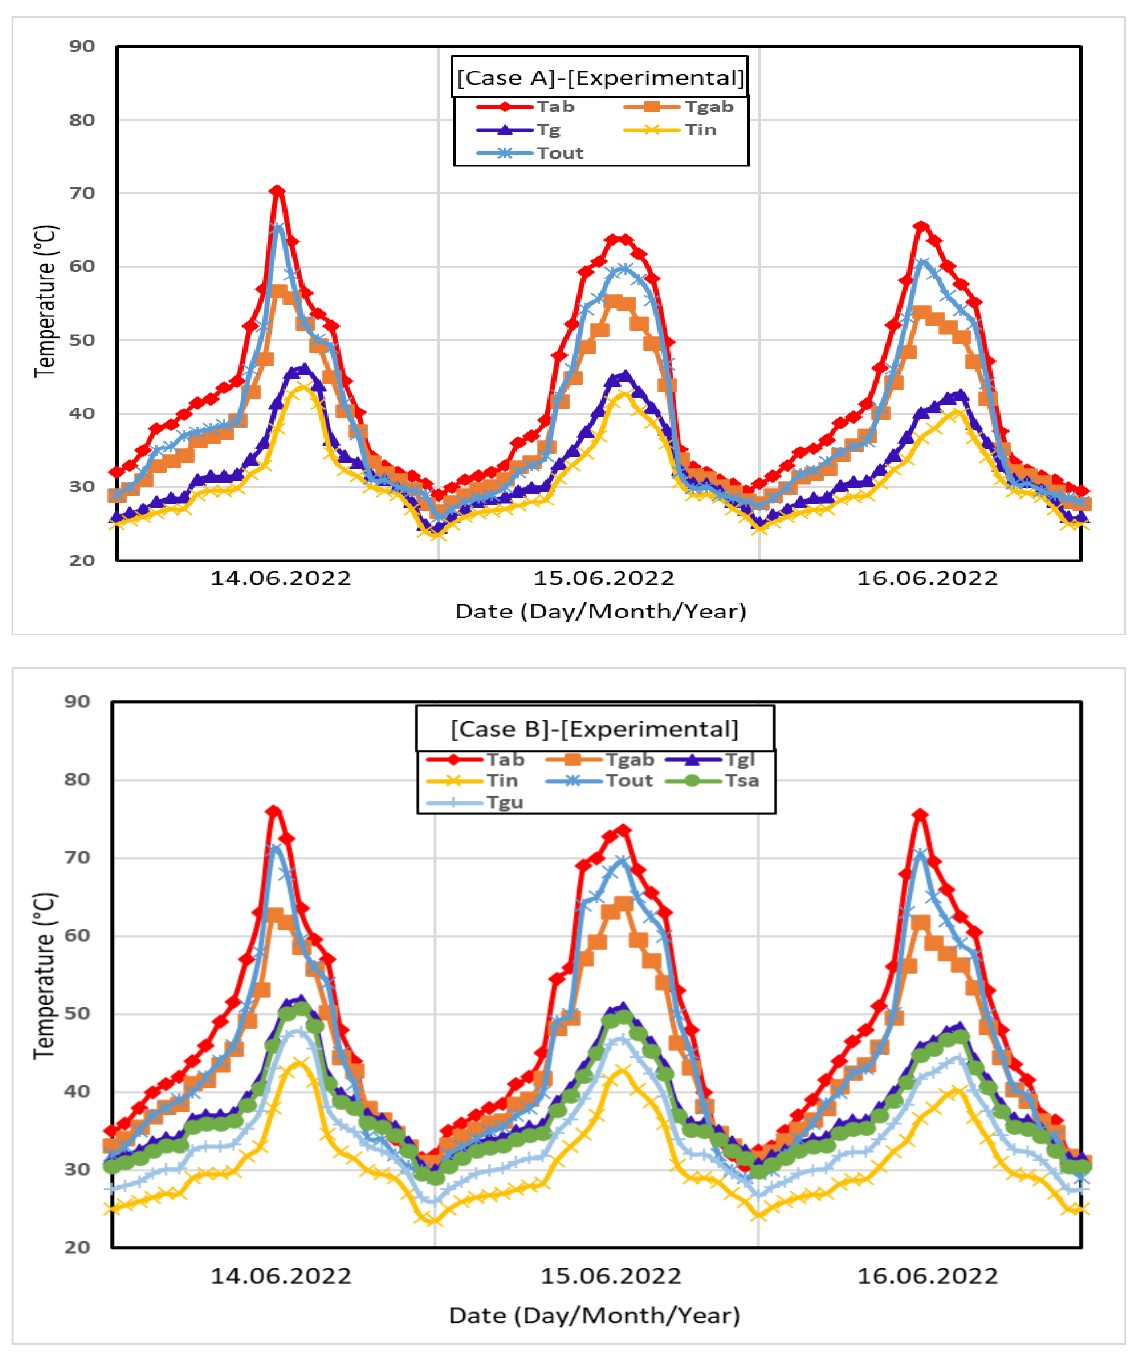
Figure 9. Temperature evolution of the components and the two tested FPSAHs. The temperature contours for the absorber and upper glass cover for both tested Case A and Case B at different time intervals on 15 June 2022 are shown in Figures 10 and 11, respectively. The coding color for the temperatures is shown in the charts in Kelvin. The color “blue” shows the minimum temperature values, and the color “red” indicates the maximum temperature values. The temperature contour charts of the flat-plate absorber and the upper glass cover suggest that: